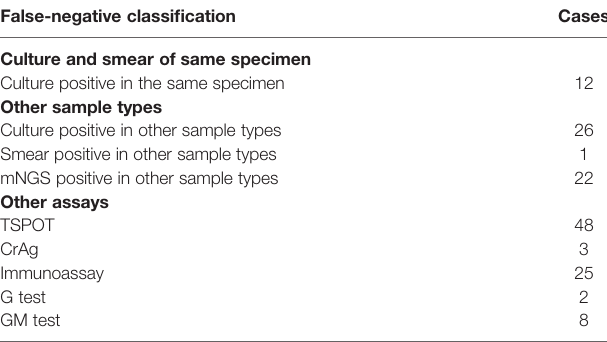
TABLE 3 | Classi fi cation of false-negative